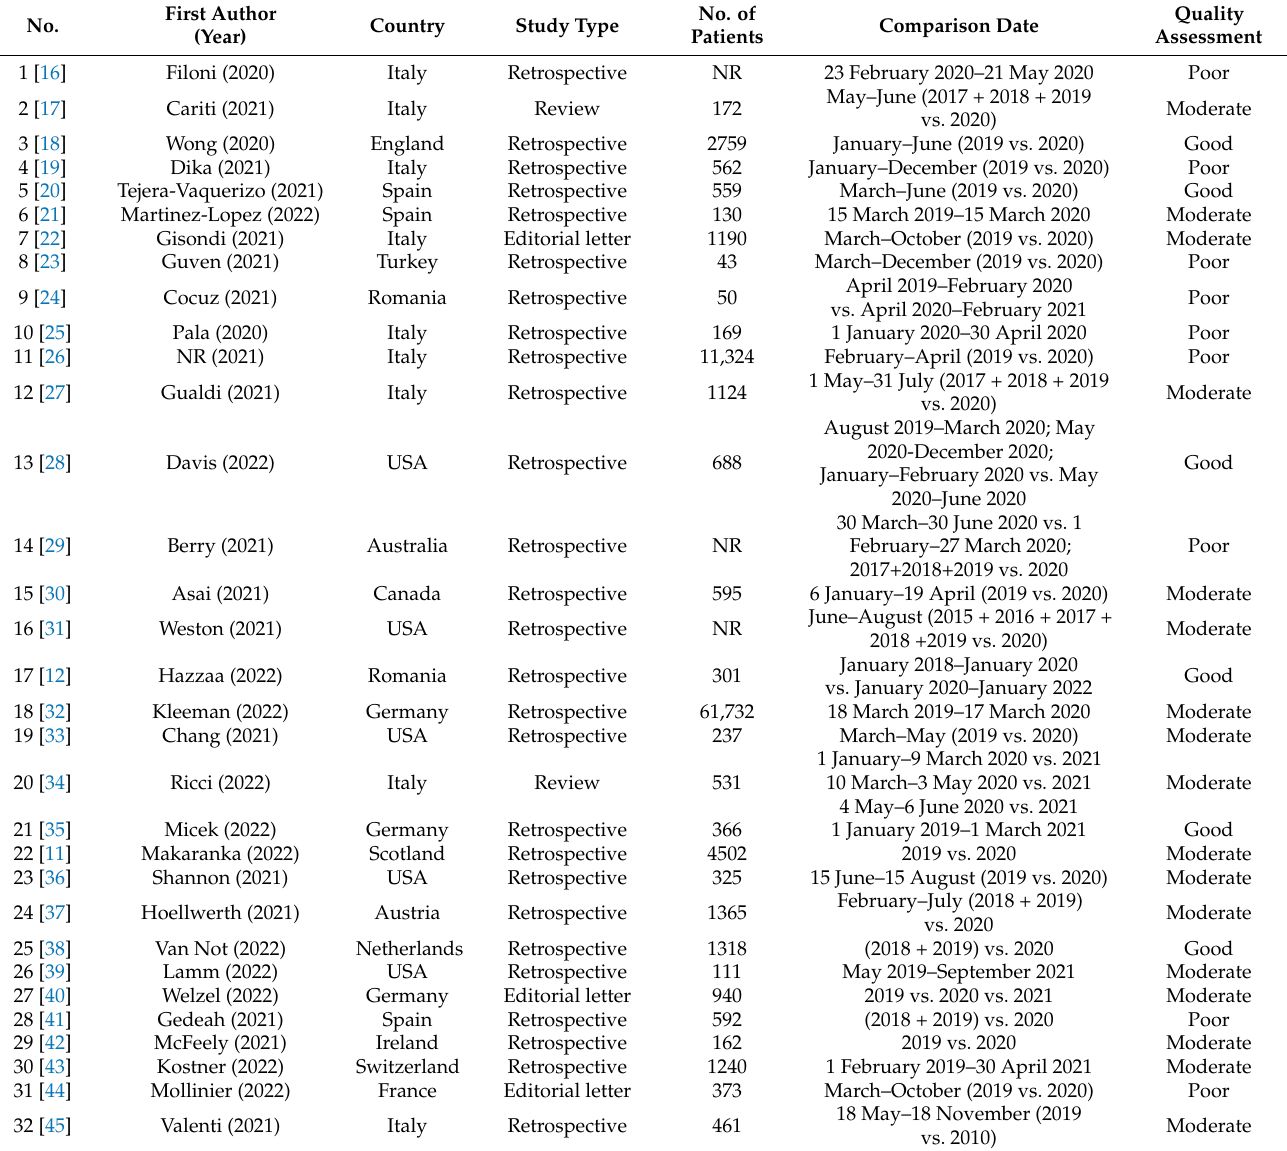
Table 1. Studies included in the